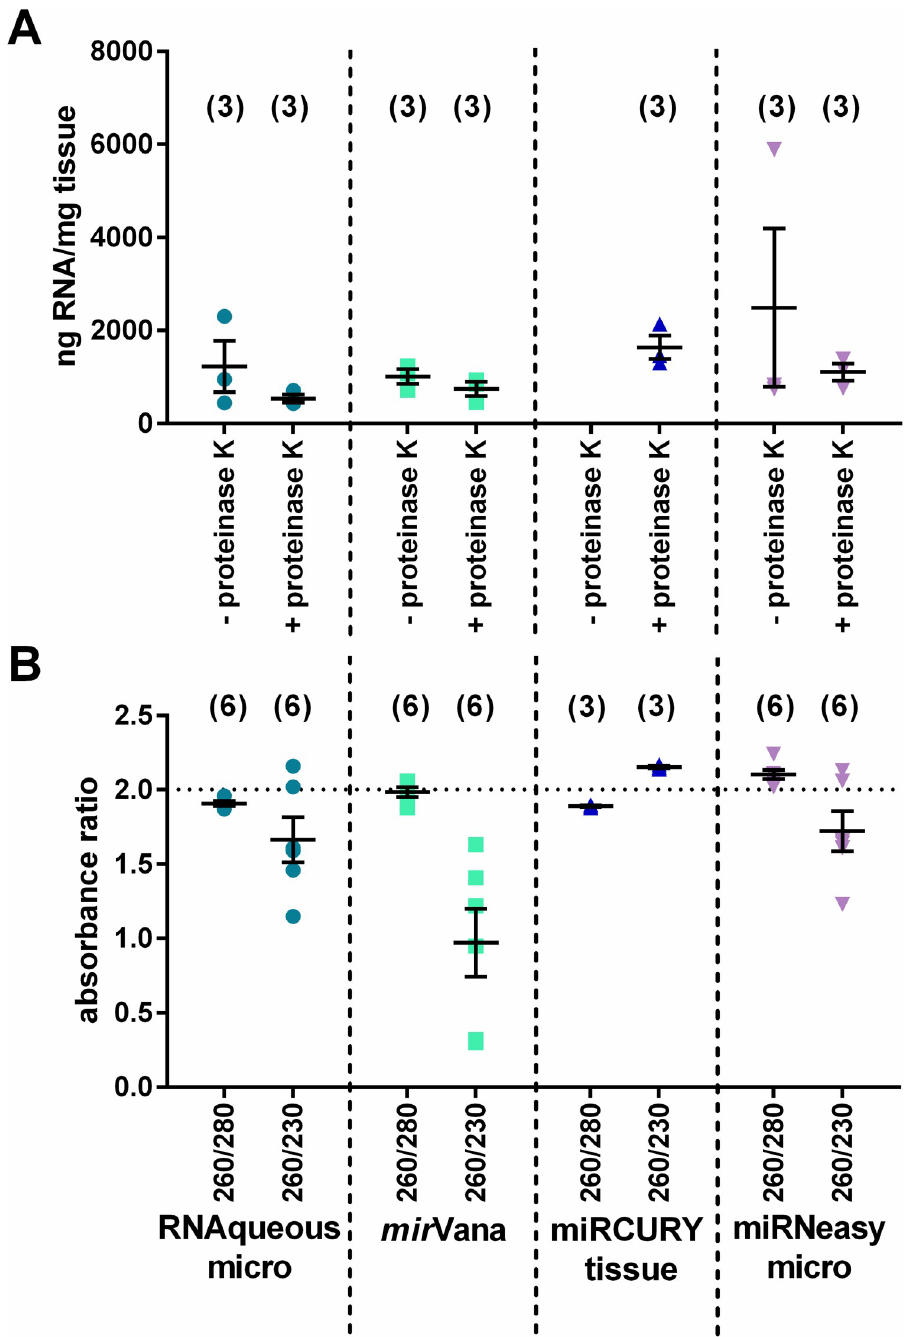
Fig 2. Spectrophotometry analysis of pig LV biopsy RNA. RNA extracted according to each manufacturer’s protocol, with the addition of a proteinase K digestion in half the samples. n = 3 biopsies/experimental condition, mean ± SEM. N . B . Exiqon miRCURY tissue protocol requires proteinase K, therefore no–proteinase K condition was done with this kit. (A) RNA yield, assessed as ng RNA recovered per mg input tissue, was not significantly different between the protocols (Kruskal-Wallis test with Dunn correction), and additional proteinase K digestion in the RNAqueous micro, mir Vana and miRNeasy micro protocols did not significantly improve RNA yield (Kruskal-Wallis test with Dunn correction). (B) 260/280 and 260/230 ratios provide an assessment of the purity of the RNA. Ratio < 2.0 indicates possible contamination with protein, phenol or salts. All protocols produced an acceptable 260/280 ratio. RNA extracted using the mir Vana protocol had low 260/230 ratios, indicating probable phenol or guanidine carryover. Numbers in brackets indicate the number of samples in each group.